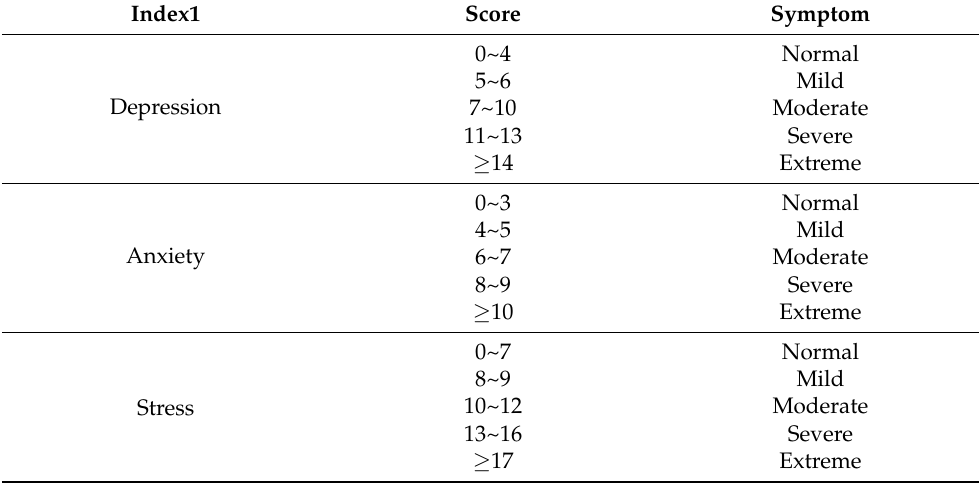
Table 1. Three scale score classification